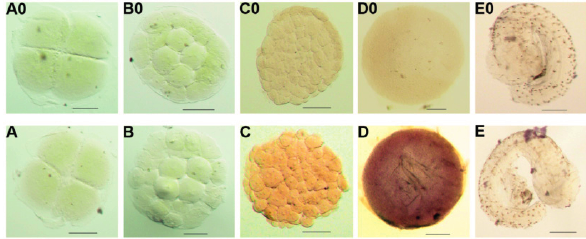
Figure 8. Expression of Po-prdm14 mRNA during early embryogenesis by whole mount in situ hybridization. The positive cells with anti-sense probe hybridization were stained pink or purple ( A – E ), whereas the negative controls with sense probe hybridization remained unstained (A0-E0) at the ( A ) 4-cell; ( B ) 16-32 cell; ( C ) morula; ( D ) early gastrula, and ( E ) tail bud stages. Scale bars, 100 µm. ISH results revealed that the Po-prdm14 mRNA-positive signals were the strongest in the early-gastrula stage and present in all blastomeres. Similarly, no signals of Po-prdm14 mRNA were detected in the 4-cell, 16-cell, morula and tailbud